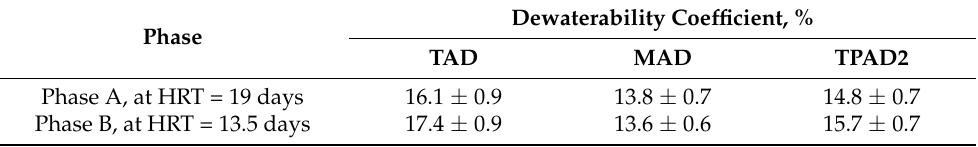
Table 6. Dewaterability coefficient of the digestates from MAD, TAD and TPAD